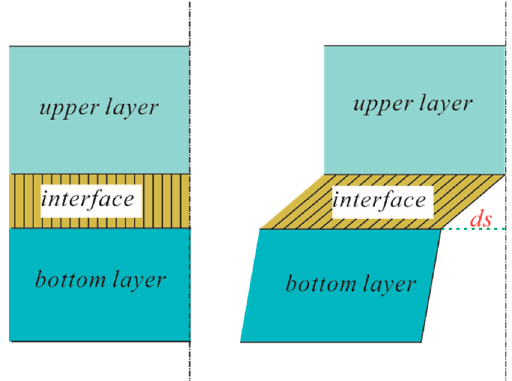
Figure 13. Discordant deformation ( ds ) caused by interface.